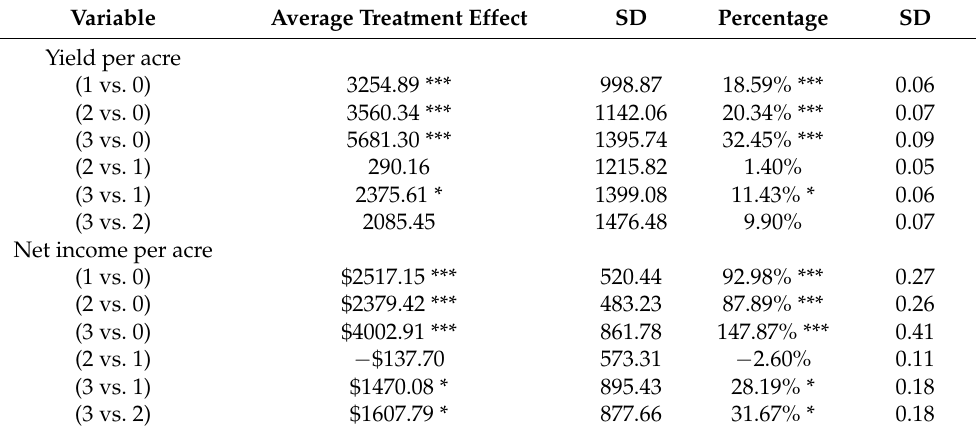
Table 4. Average treatment effect of yield per acre and net income per acre based on the IPWRA